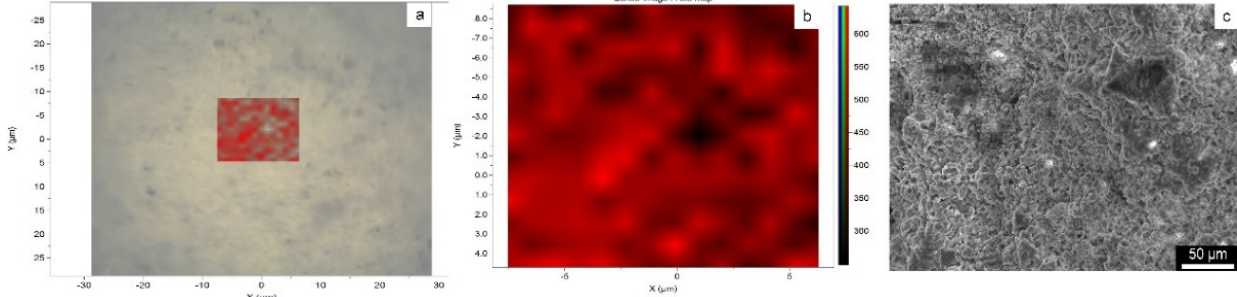
Figure 7. Field exposure results after one year. ( a ) Micrograph, ( b ) Raman mapping, ( c )